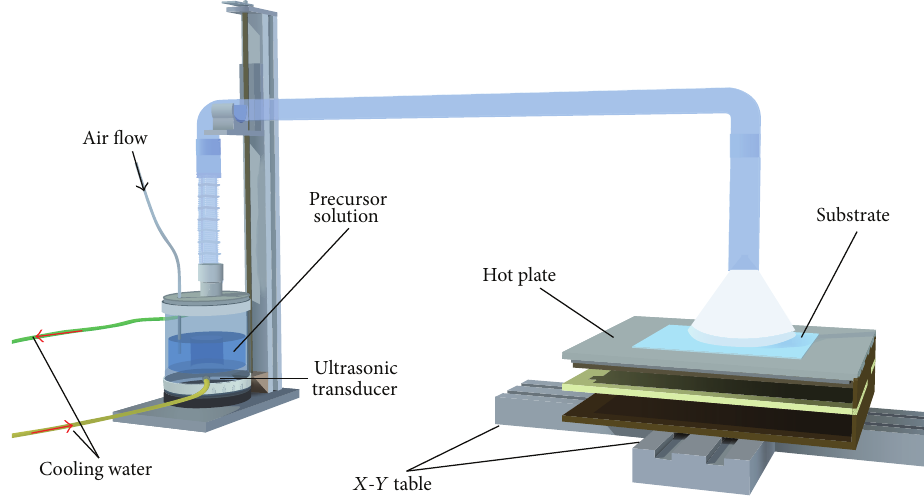
Figure 1: Schematic of ultrasonic spray